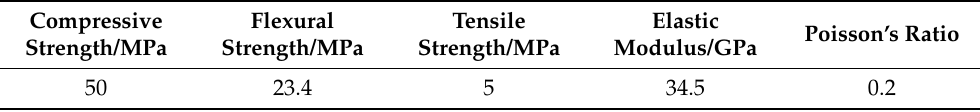
Table 2. Basic properties of ECC